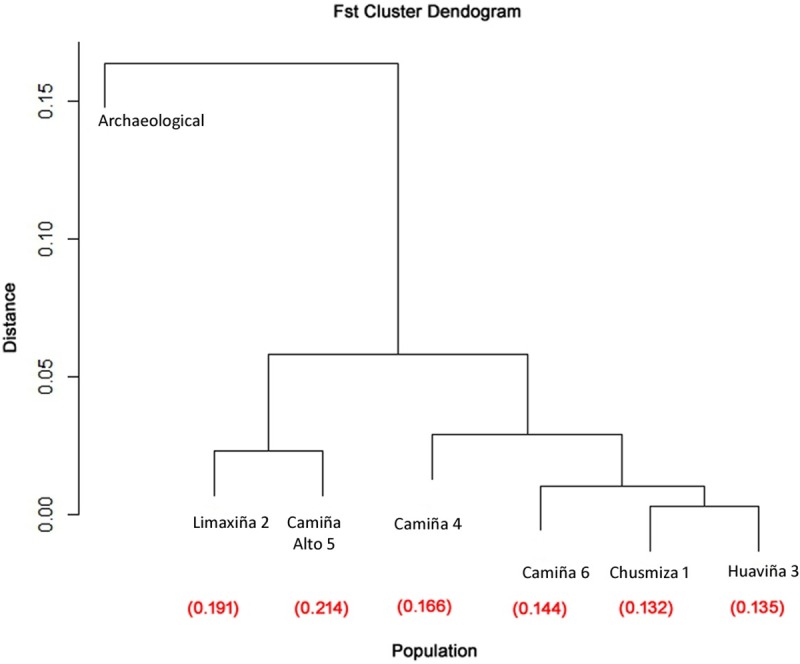
Cluster dendrogram for FST values for modern and archaeological populations.Three major groups are observed; modern populations Limaxiña 2 and Camiña Alto 5 are grouped in one branch, populations Chusmiza 1, Huaviña 3, Camiña 4 and Camiña 6 are grouped in a second branch, and the archaeological population) is distant from the rest. Fst value between archaeological and modern populations are listed below each population.